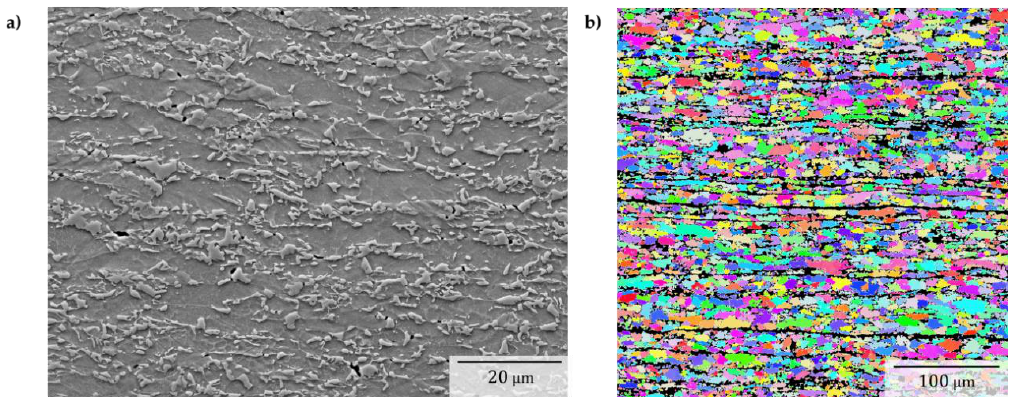
Figure 1. ( a ) Microstructure of the used dual-phase DP800 steel imaged by SEM, with visible deformation-induced voids. ( b ) Electron-backscatter-diffraction mapping of ferrite grains; martensite bands are visible as black areas.